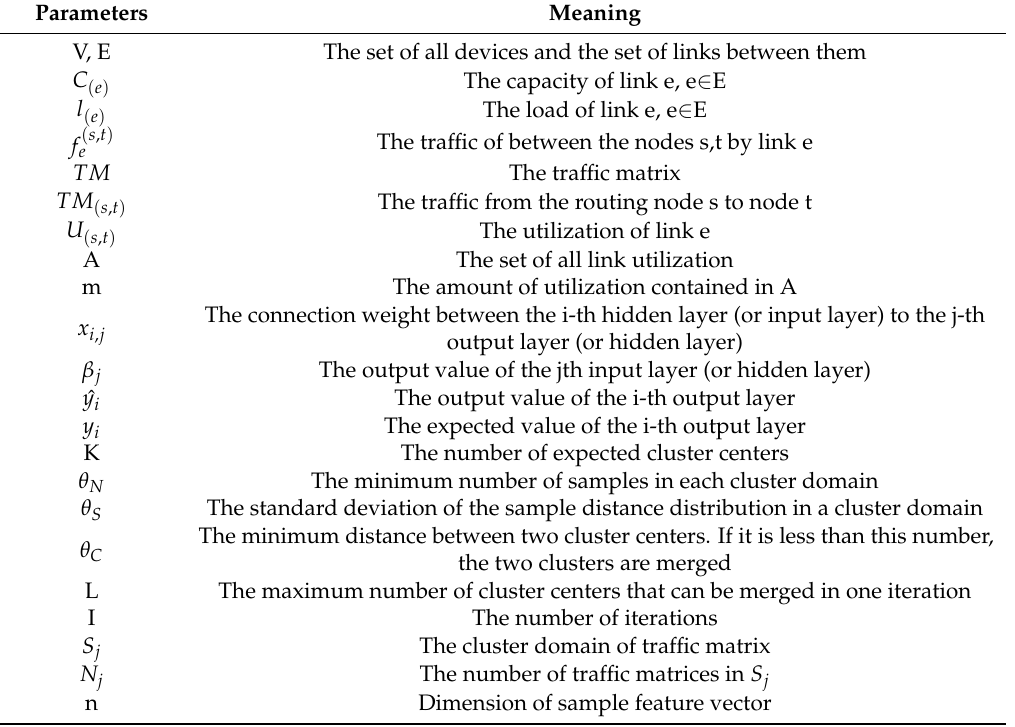
Table 1. List of Table 1. List of notation.